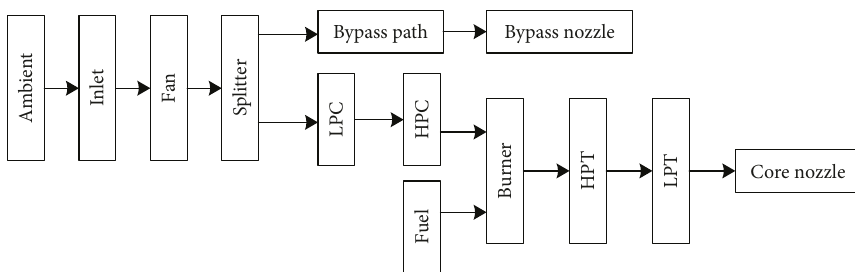
Figure 8: Connections of various modules in the simulation